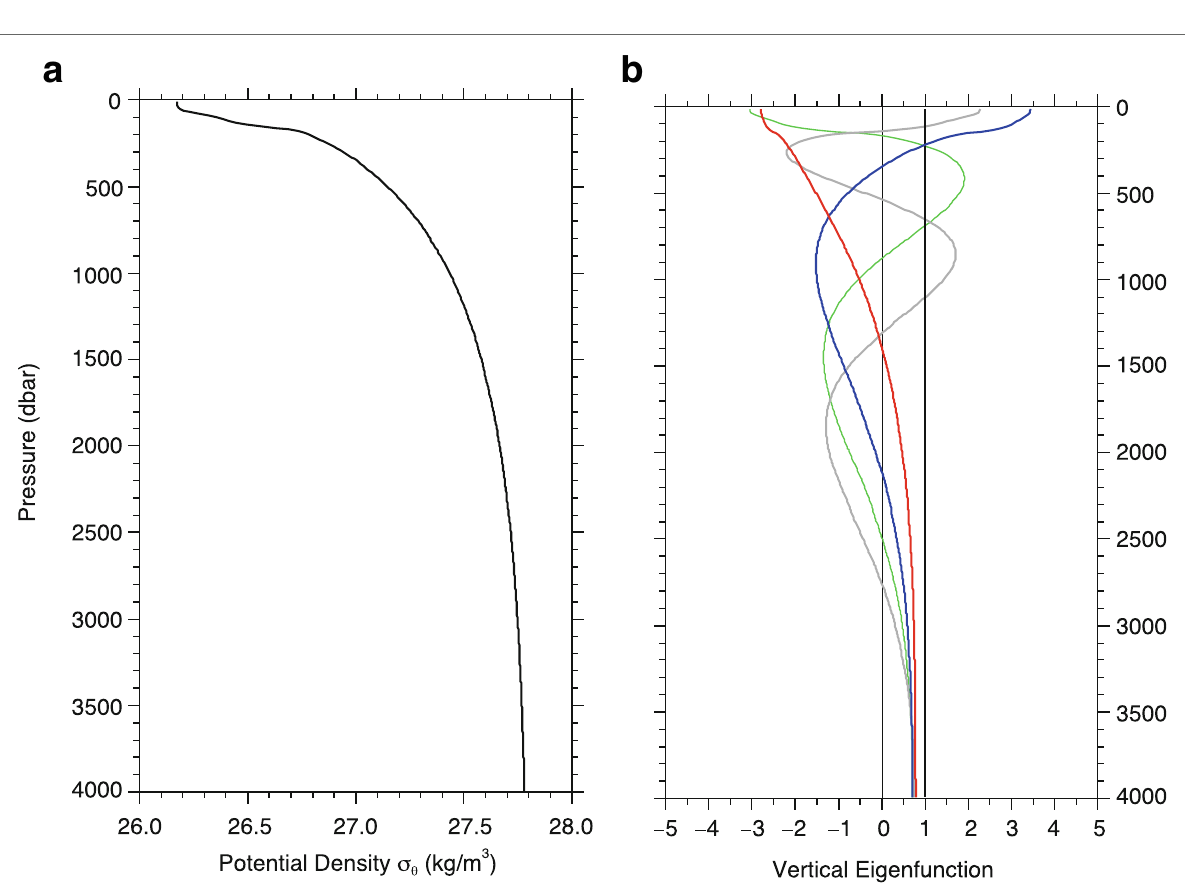
Fig. 4 a Vertical profile of the potential density, σ θ , in kg m − 3 averaged along the WOCE P01 line (47° N) from 160° E to 170 ° E. b Vertical eigenfunctions of the barotropic mode (black line), and the first (red line), second (blue line), third (green line), and fourth (gray line) baroclinic vertical modes of the potential density profile. The vertical thin solid line indicates